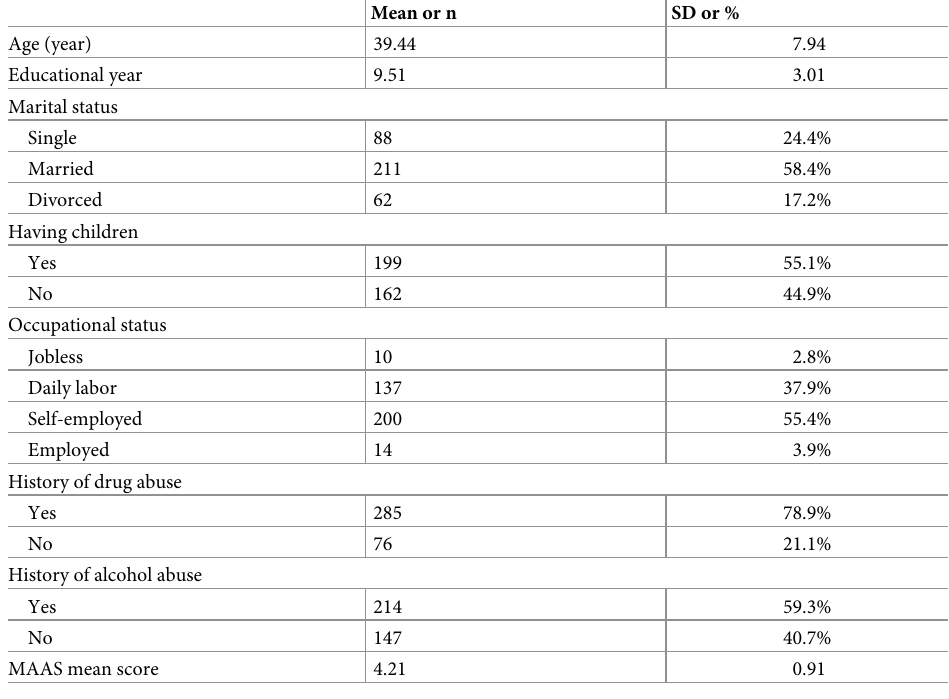
Table 1. Socio-demographic characteristics of prisoners in Rasht Lakan correctional